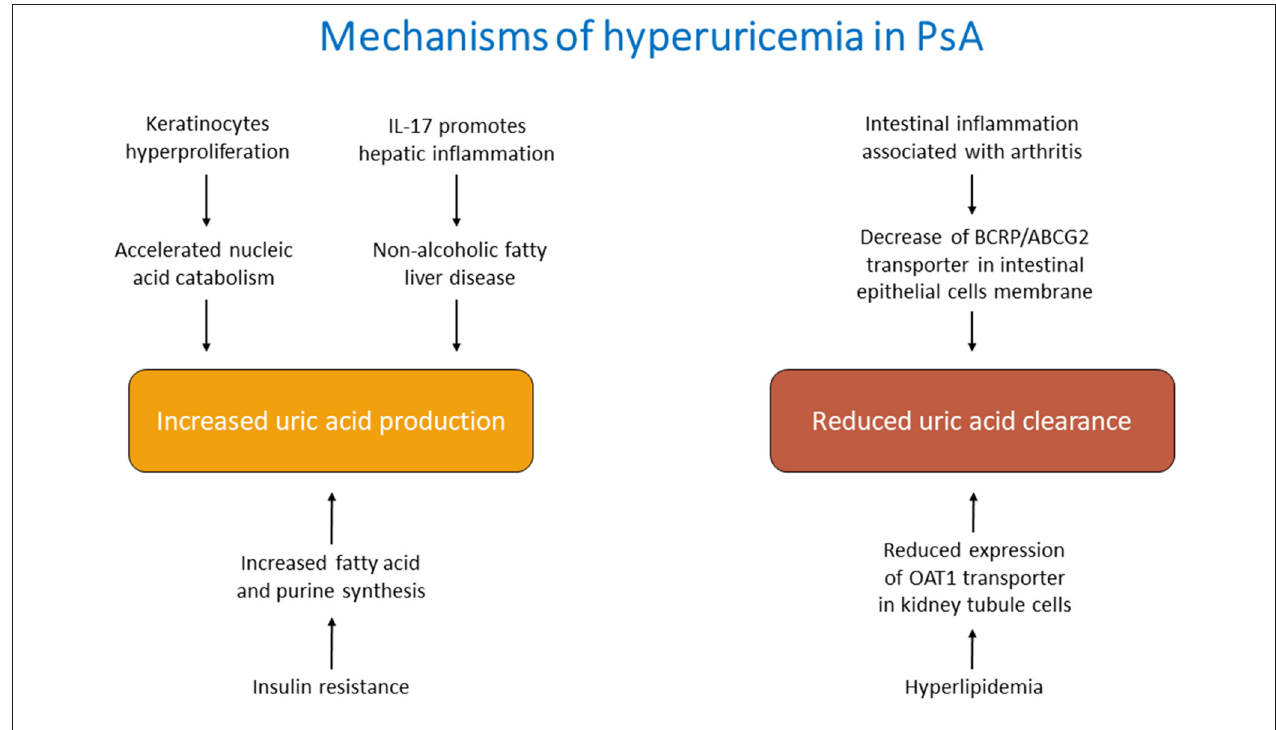
FIGURE 1 | Main mechanisms of hyperuricemia in psoriatic arthritis.